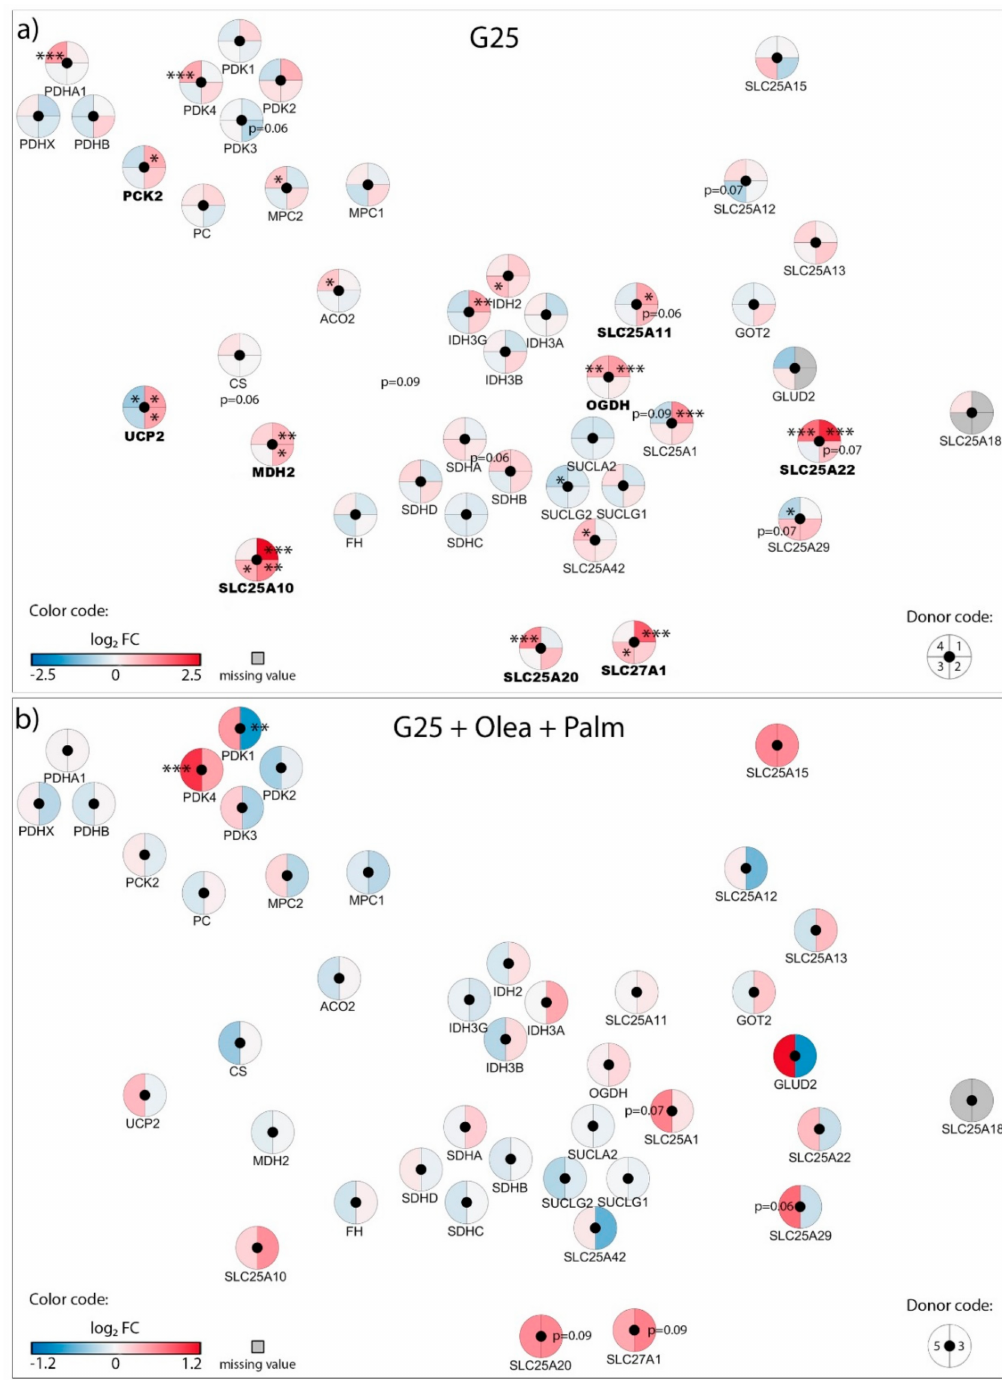
Figure 3. Effects of high 25 mM glucose (G25) and G25 plus 0.4 mM oleate and palmitate (G25 + Olea + Palm) on the transcriptional regulation of mitochondrial solute carriers and associated genes. Human islets were exposed to ( a ) G25 glucotoxic condition or ( b ) G25 + Olea + Palm glucolipotoxic condition for 3 days before RNA-Seq analysis. E ff ects of culture conditions on transcript levels are compared to standard G5.5 medium and shown as upregulated (red), downregulated (blue), or unchanged (white). Missing values are represented in grey. Each disk is split into individual changes for the di ff erent donors. Color code reflects the transcriptional changes in log 2 fold changes (log 2 FC) for that particular gene in individual donors. Clinical data from individual donors are shown in Supplementary Table S1, while quantitative transcriptional data are shown in Supplementary Table S2. * adjusted p < 0.05, ** adjusted p < 0.01, *** adjusted p < 0.001 between control 5.5 mM glucose and the specific culture